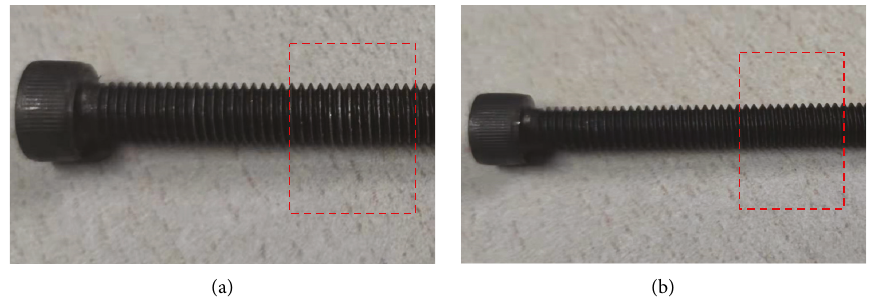
Figure 30: Thread comparison. (a) A used bolt. (b) A new